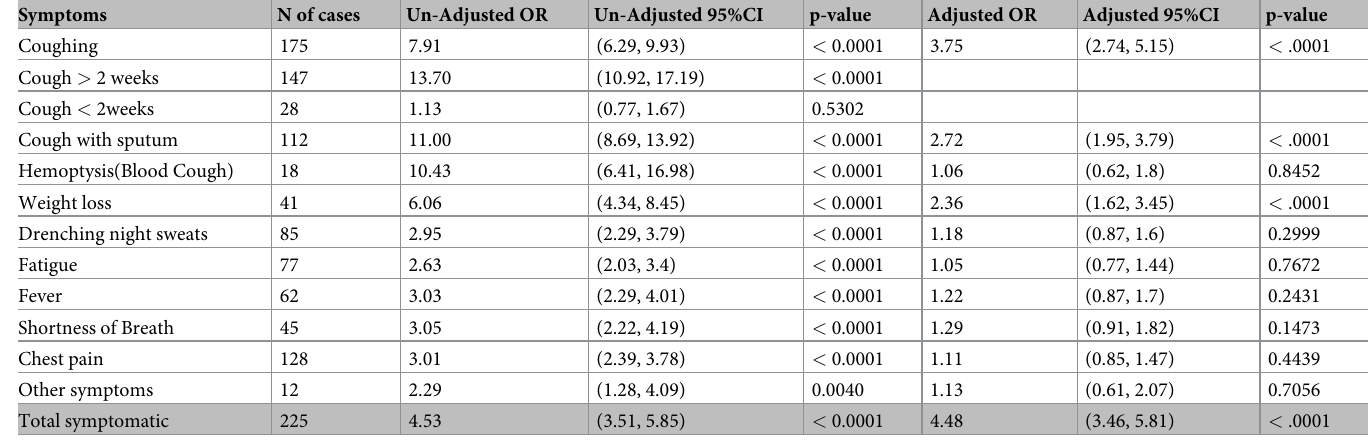
Table 6. Association between being diagnosed with tuberculosis with presence of tuberculosis-related